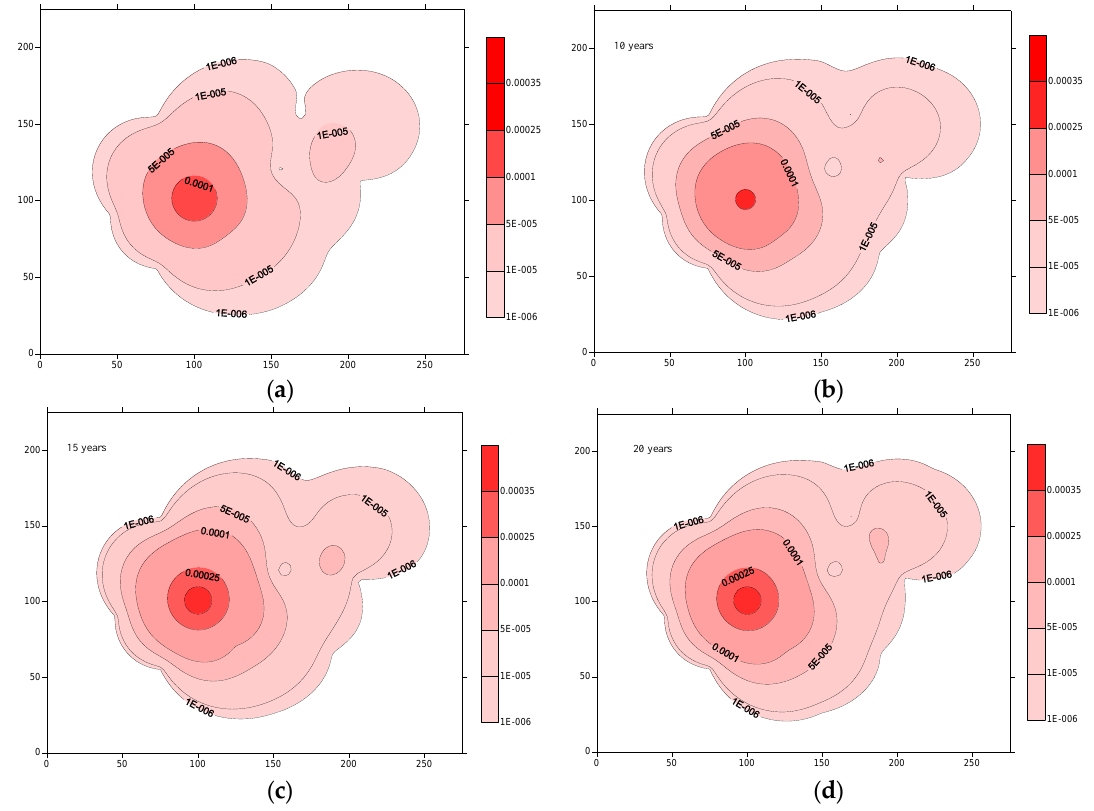
Figure 5. Predicted risk levels for four remediation duration when the environmental standard is 150 μg/L and the acceptable health risk level is 0.00044, where (a), (b), (c), (d) are results under the conditions of remediation duration values being 5, 10, 15 and 20 years, respectively.